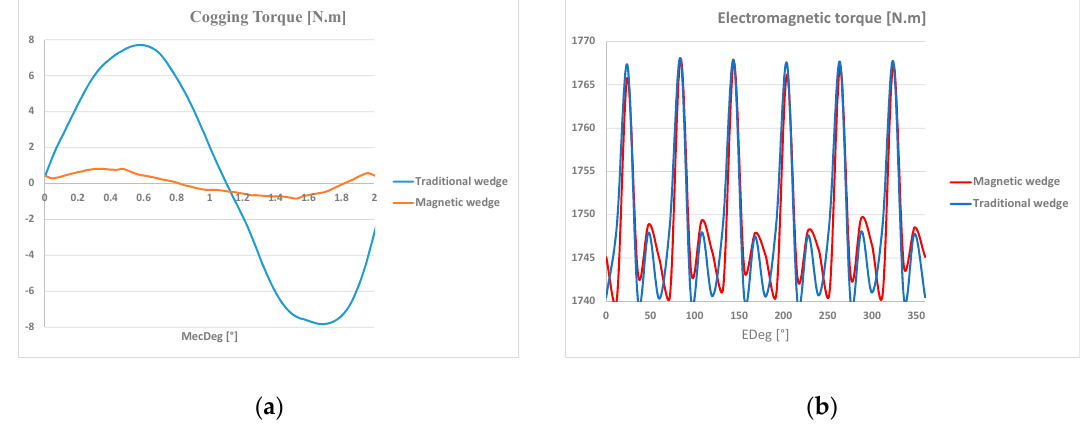
Figure 13. ( a ) Cogging torque under no load; ( b ) Torque at full load.